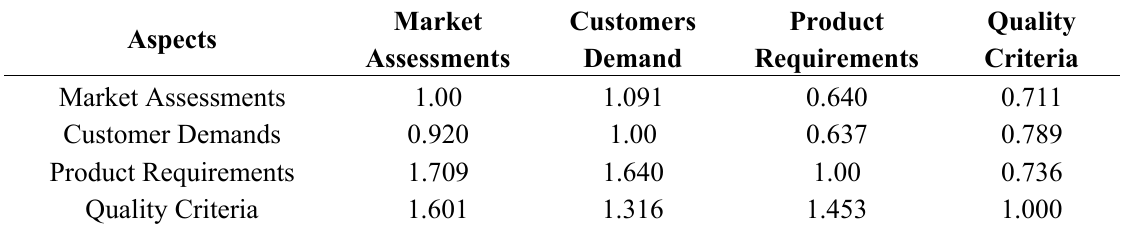
Table 9. Pair-wise Comparison Matrix after Defuzzification.